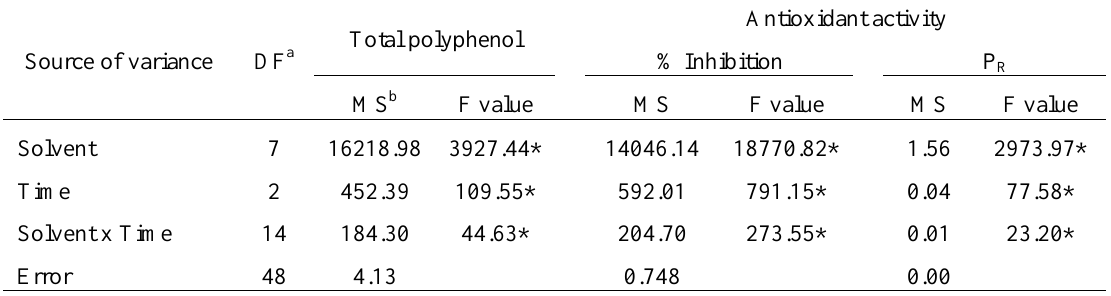
Table 2. Variance analysis results on the effect of solvent type, extraction time and their interactions on total polyphenol and antioxidant activity of black tea determined by two different methods.